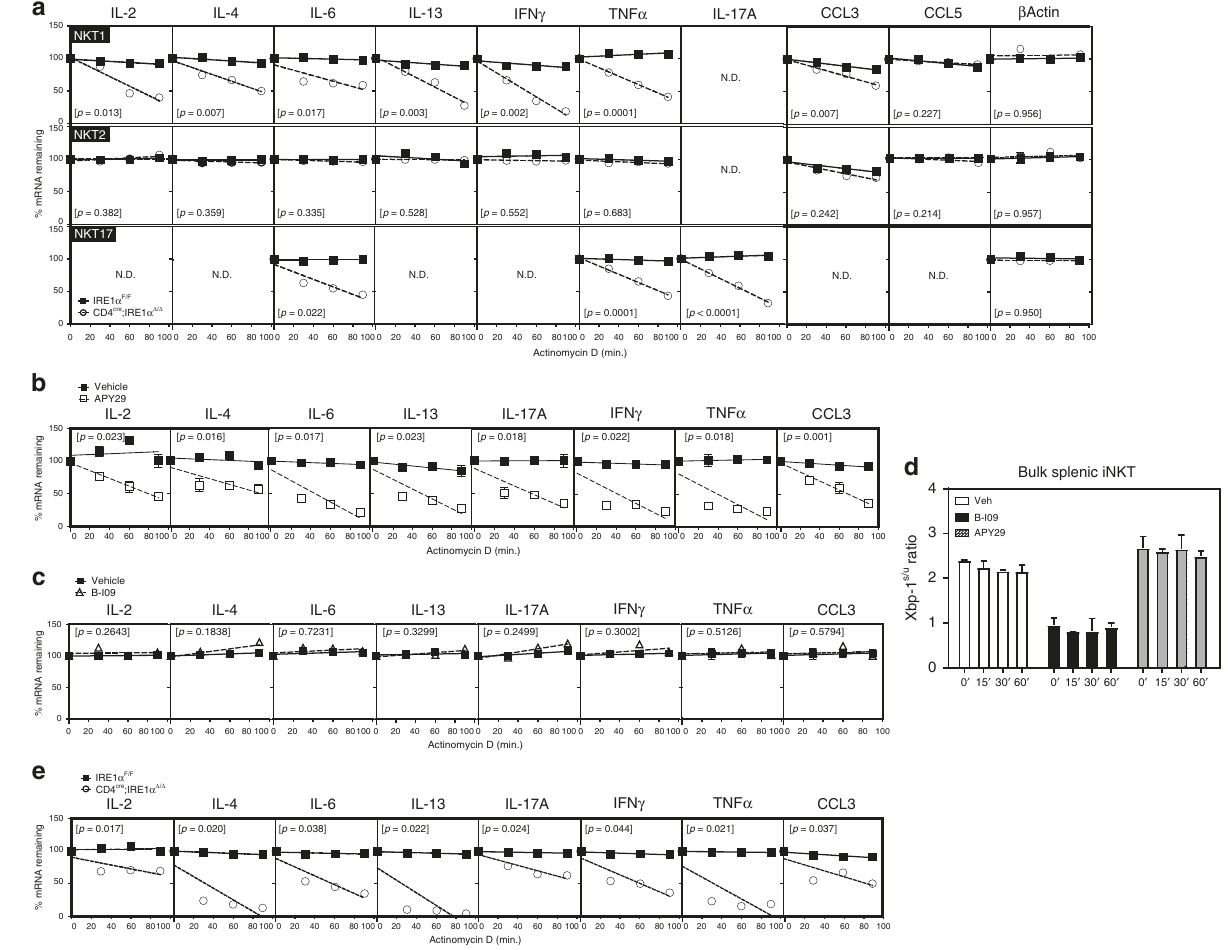
Fig. 4 Reduced cytokine mRNA stability in IRE1 α -de fi cient iNKT cells. a Splenic NKT1, 2 and 17 cells were isolated from control ( n = 4) and CD4 cre ;IRE1 α Δ / Δ ( n = 4) mice, expanded and restimulated with anti-CD3/CD28 for 3 h prior to addition of actinomycin D. mRNA decay rates were determined by linear regression analysis. Data represent three independent experiments pooled. b − d Bulk splenic wild-type iNKT cells were expanded in vitro, restimulated with anti-CD3/CD28 for 3 h in the presence of APY29 and B-109, and then treated with actinomycin D. mRNA decay rates were determined as above. Data represent two independent experiments pooled. e Puri fi ed bulk splenic iNKT cells from control ( n = 6) and CD4 cre ;IRE1 α Δ / Δ ( n = 6) mice were restimulated ex vivo with α -CD3/CD28 for 3 h, prior to addition of actinomycin D. Data represent two independent experiments pooled. Error bars show the mean ± s.e.m. p < 0.05 determined by linear regression analysis and ANOVA, n.d. not